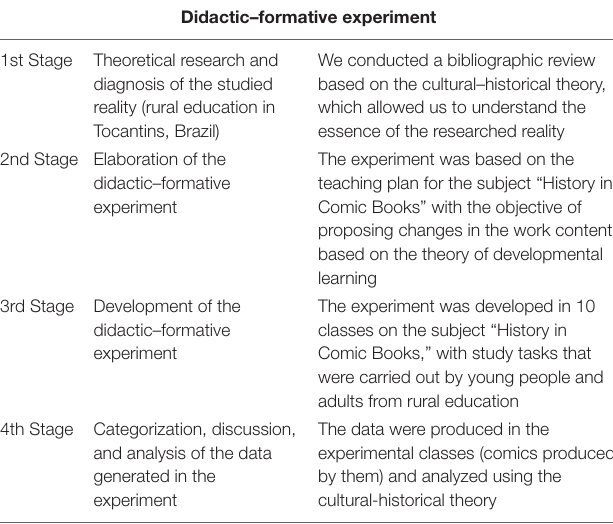
TABLE 1 | Experimental didactic system